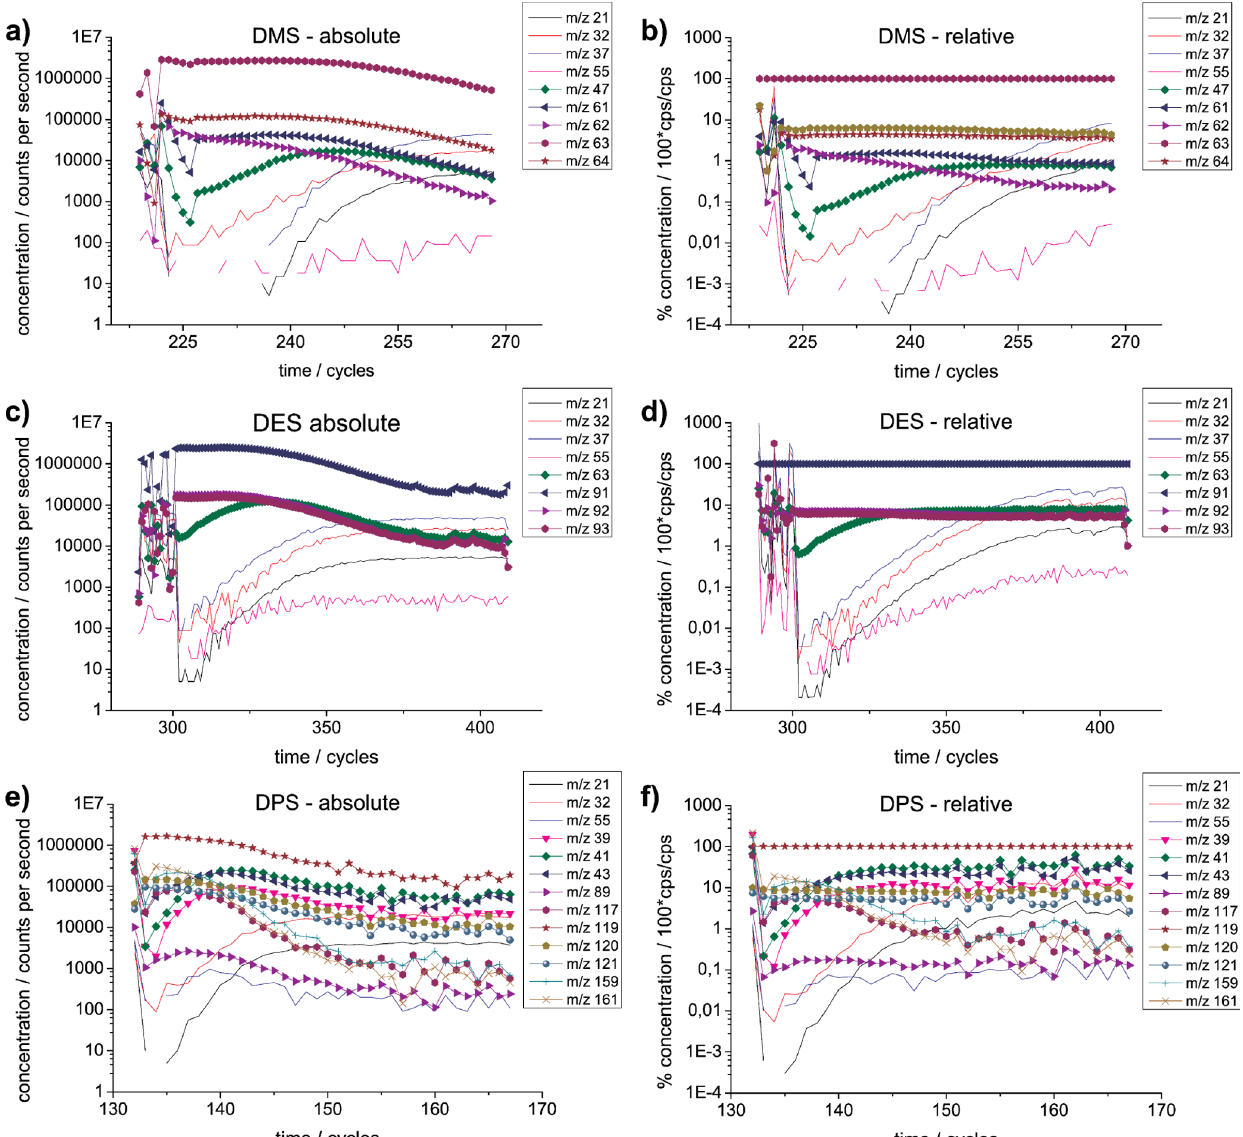
Figure 1. Experimental PIDK results. Primary ion depletion studies of (a), (b) dimethyl sulfide (DMS), (c), (d) diethyl sulfide (DES), (e), (f) dipropyl sulfide (DPS), of absolute (a), (c), (e) and relative (b),(d),(f) concentrations. Relative concentrations are given in percent of MH + (for DMS: m/z 63, for DES m/z 91, for DPS m/z 119). Reagent ions: primary ion m/z 19 (monitored via its isotopologue at m/z 21), additional primary ion m/z 37 and m/z 55 and parasitic ion m/z 32 are displayed as solid lines for easier distinguishing from reactant ions MH + and fragments, which are displayed as lines + symbol. The time (in cycles) is given from the start of the depletion reaction (and resulting short term instabilities in concentrations) with a maximum depletion as seen in the depletion of primary ion m/z 21 until the return to regular non-depleted conditions. Reactant M concentration was changed quasi-logarithmically via a controlled dilution method. Changes in the ion fragmentation abundances are due to primary ion depletion.